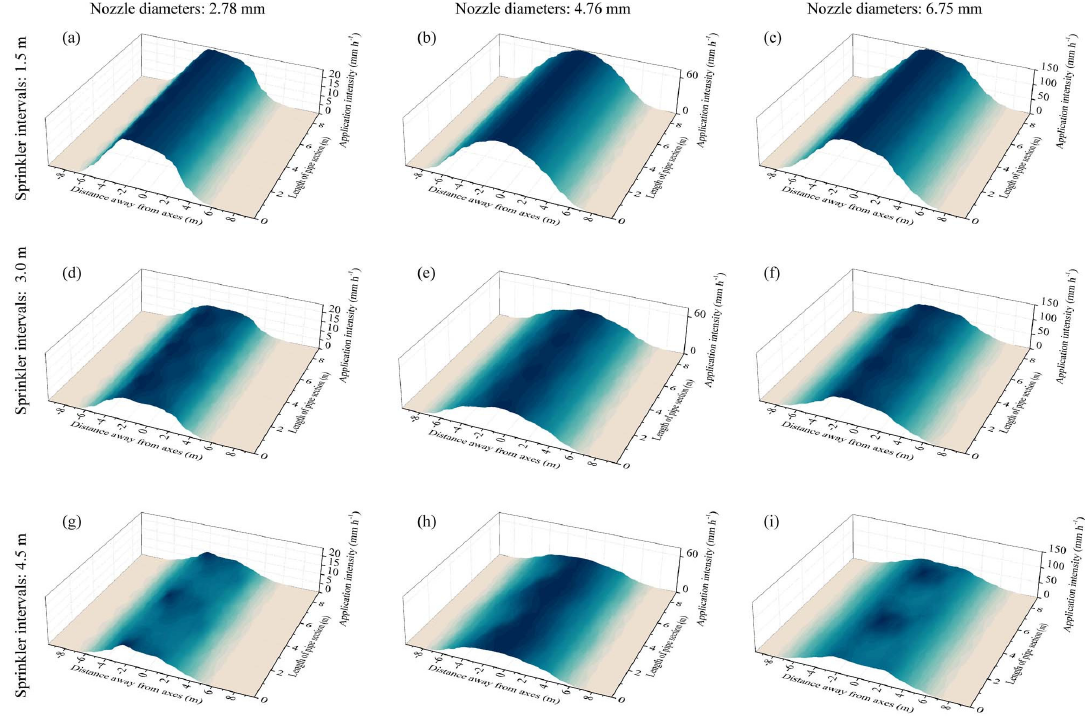
Figure 7. Water distribution characteristics of same-nozzle-sprinkler pipe sections with rotating spray plate sprinklers (RSPSs). The figures in different columns and rows indicate different nozzle diameters (2.78, 4.76, and 6.75 mm) and sprinkler intervals (1.5, 3.0, and 4.5 m): RSPS—2.78—1.5 ( a ), RSPS—4.76—1.5 ( b ), RSPS—6.75—1.5 ( c ), RSPS—2.78—3.0 ( d ), RSPS—4.76—3.0 ( e ), RSPS—6.75—3.0 ( f ), RSPS—2.78—4.5 ( g ), RSPS—4.76—4.5 ( h ) and RSPS—6.75—4.5 ( i ).